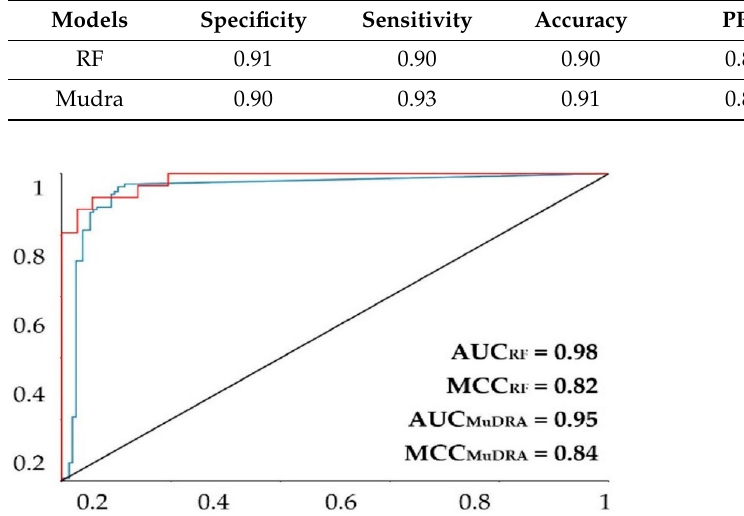
Table 2. Summary of parameters corresponding to the results obtained for all models.